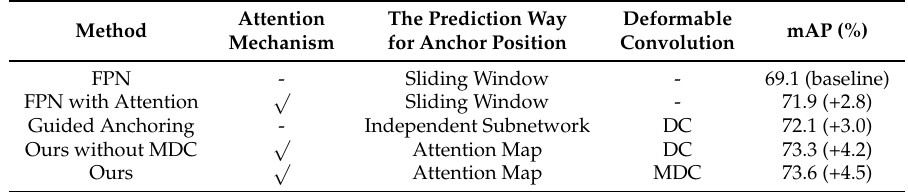
Table 2. The influence of different aspects on the detection results, where DC means deformable convolution, MDC denotes modulated deformable